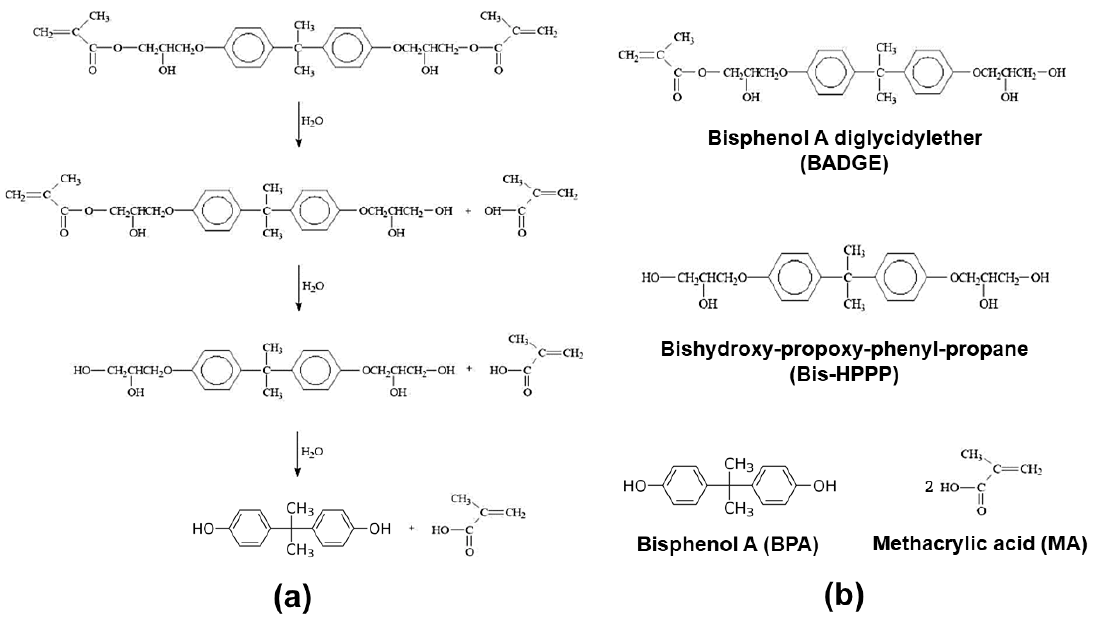
Figure 4. Hydrolysis of resin component: ( a ) the hydrolysis step of bis-GMA [29] ; ( b ) the types of decomposition products.